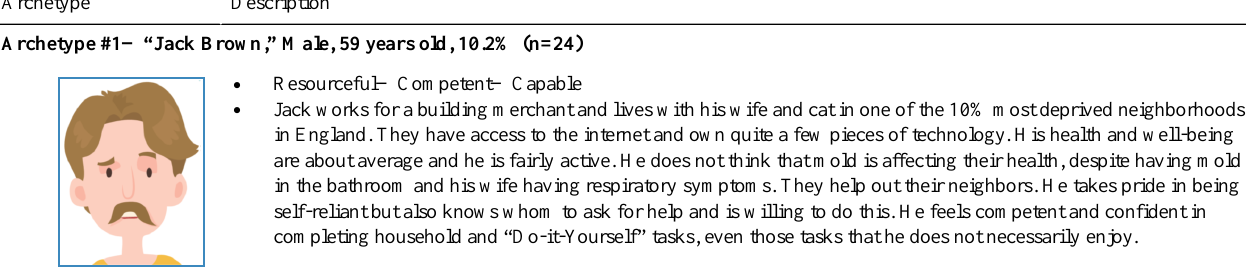
Table 2. The Smartline Archetypes (the percentages are the percentage of the 235 participants in each archetype).